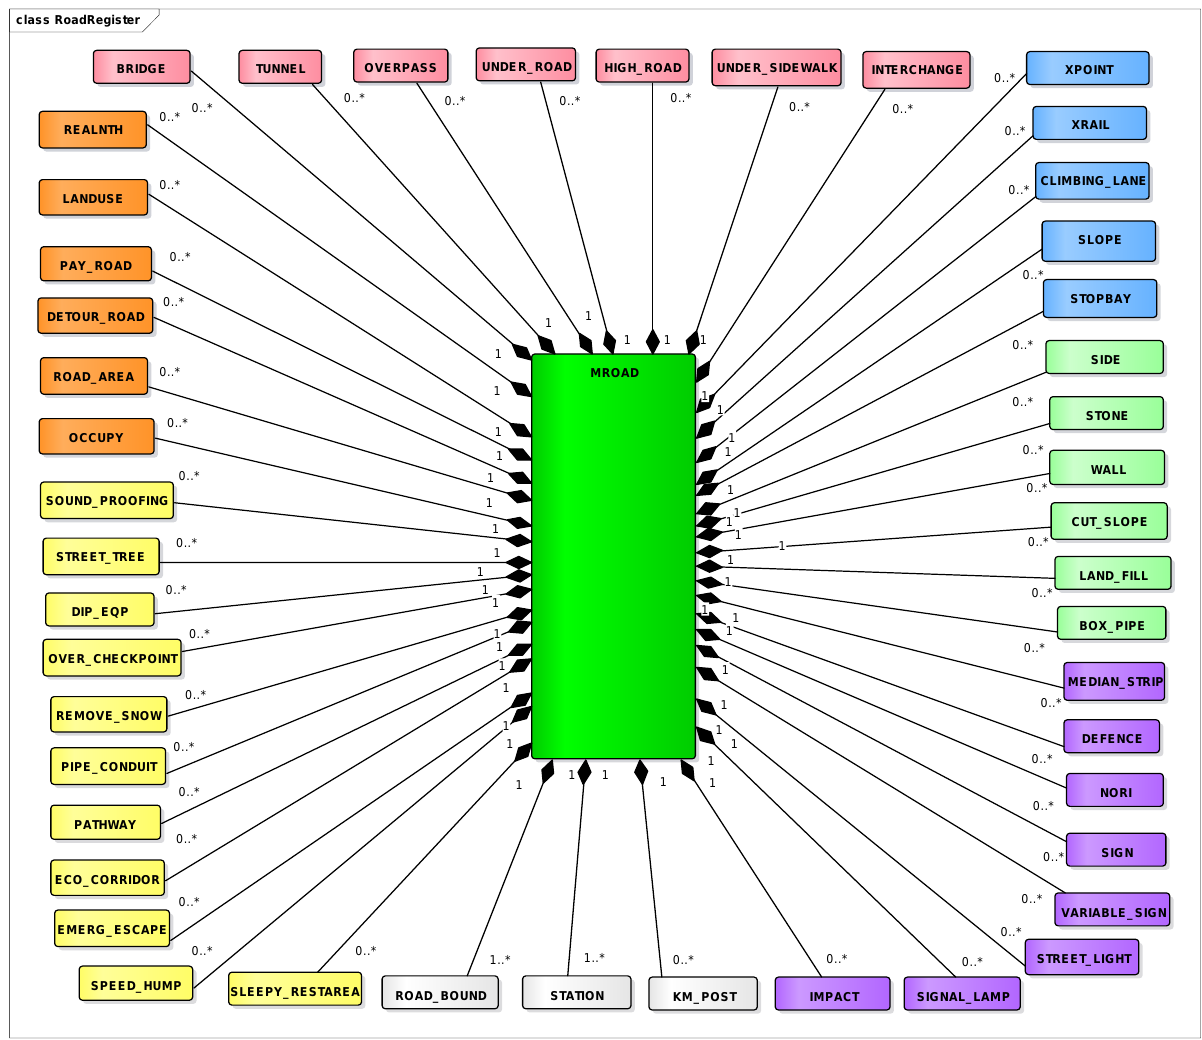
Figure 3. Classes of the road